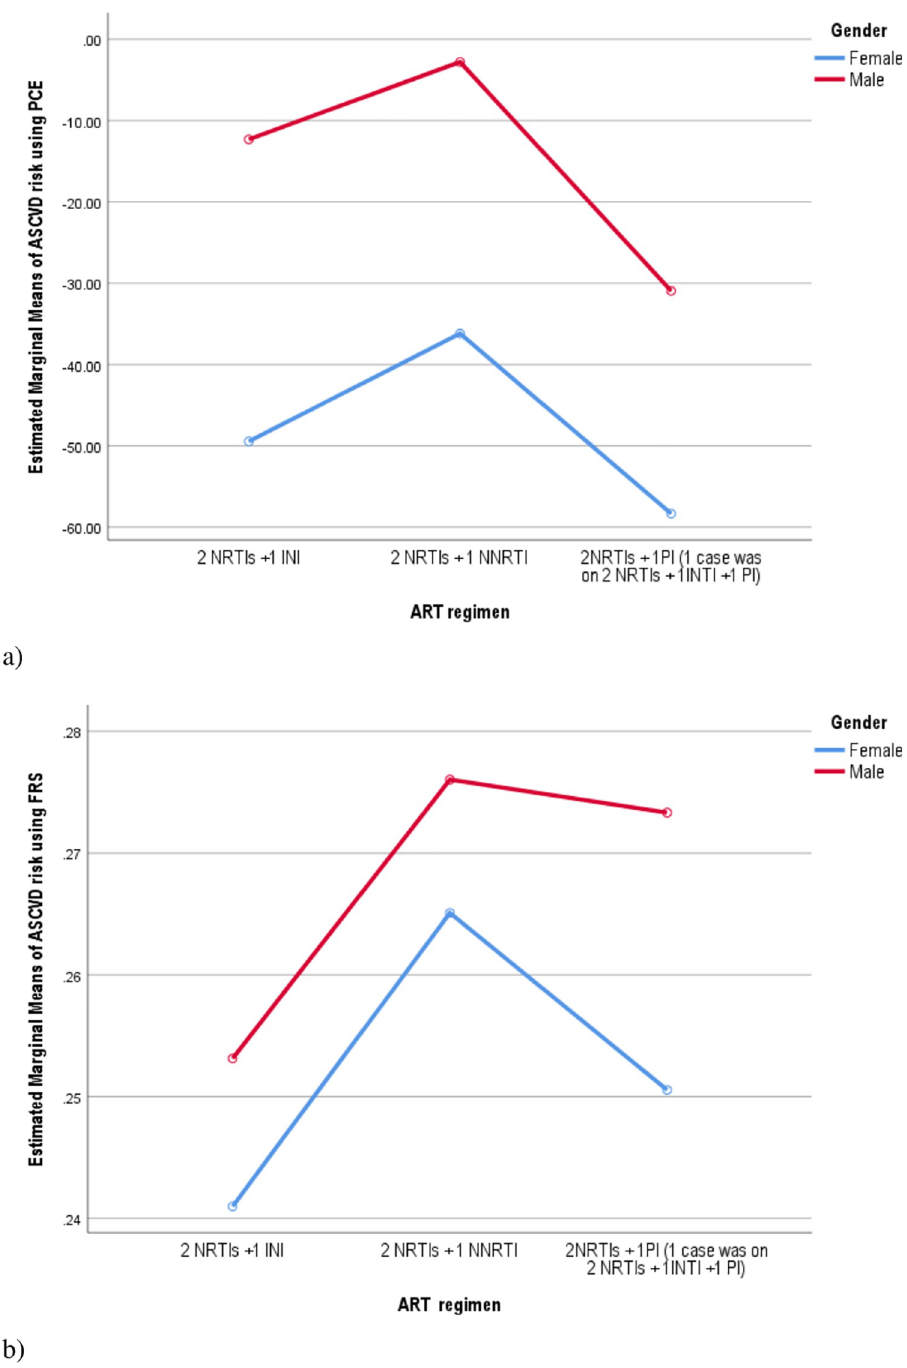
Fig 3. The ASCVD risk based on ART regimen and gender interaction among PLWHA age 40–79 years: using the pooled cohort equation (a), and the Framingham risk score (b) estimation.